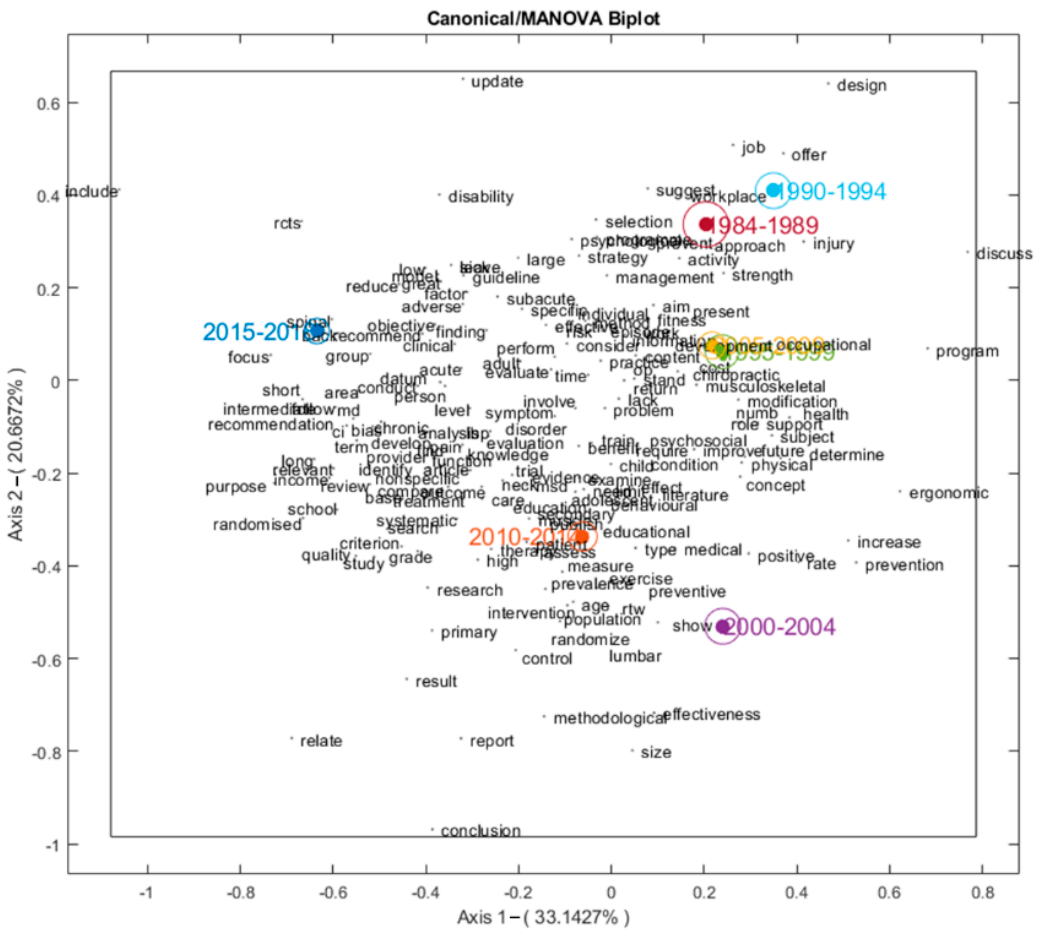
Figure 12. SRL in health sciences (low back pain prevention) using Reinert’s method.